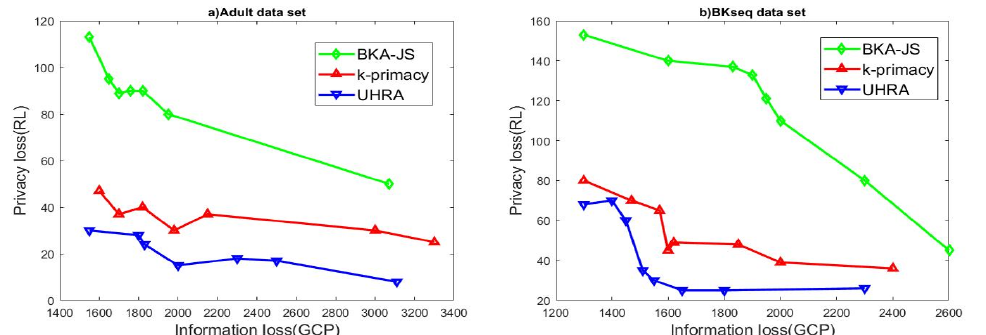
Figure 3. R-U map regarding various t